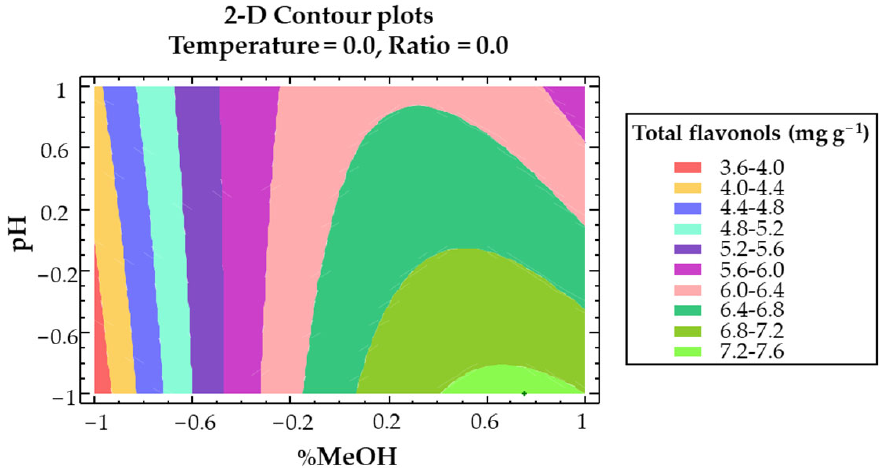
Figure 4. A 2D contour plot of the BBD using RSM to represent the effect of the solvent composition and pH on the Y TF response variable.